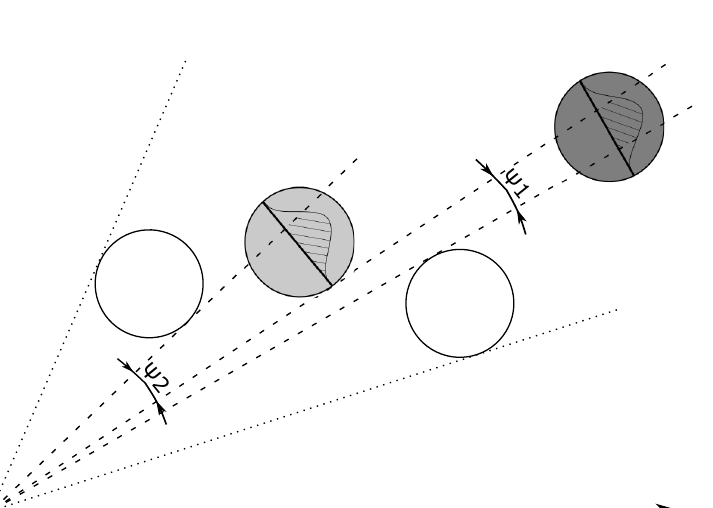
Figure 1. Schematics of the occlusion model used to estimate the detection probabilities of road vehicles. The grey objects are partially covered by the white objects, as seen from the radar’s perspec- tive. The probability of detection is proportional to the hatched area under the curve representing object